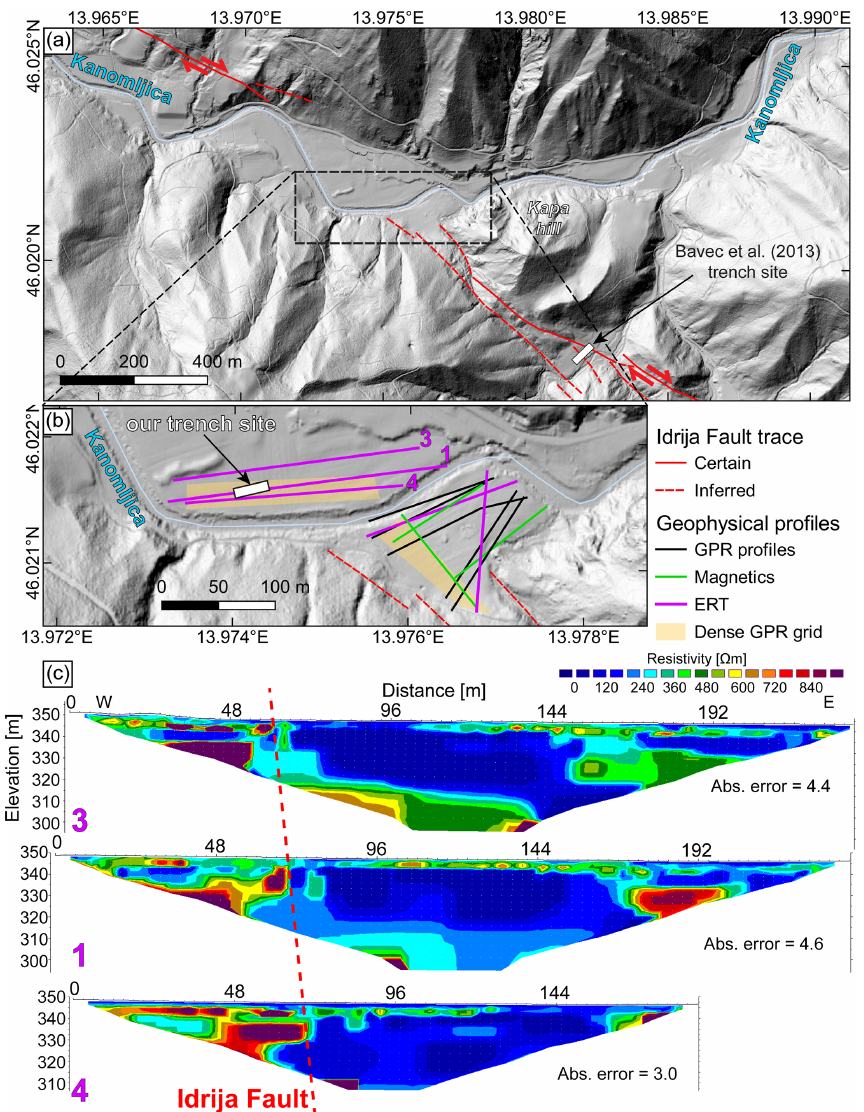
Figure 10. Map of the trench site at the Idrija Fault and selected ERT data. (a) Setting of the trench site and mapped traces of the Idrija Fault after Cunningham et al. (2006), Bavec et al. (2013), and Moulin et al. (2014). The precise fault trace is unknown in the flood plain of the Kanomljica River. (b) Detailed view of the location of all geophysical profiles used for trench site selection. (c) ERT profiles 1, 3, and 4, which were crucial for trench site location. Red dashed line indicates the interpreted fault trace. All data show dipole–dipole configuration with 10 iterations in the inversion. The absolute error describes the misfit between the data and the best-fit inverse model. In (a) and (b) the hillshade is based on the 1m lidar